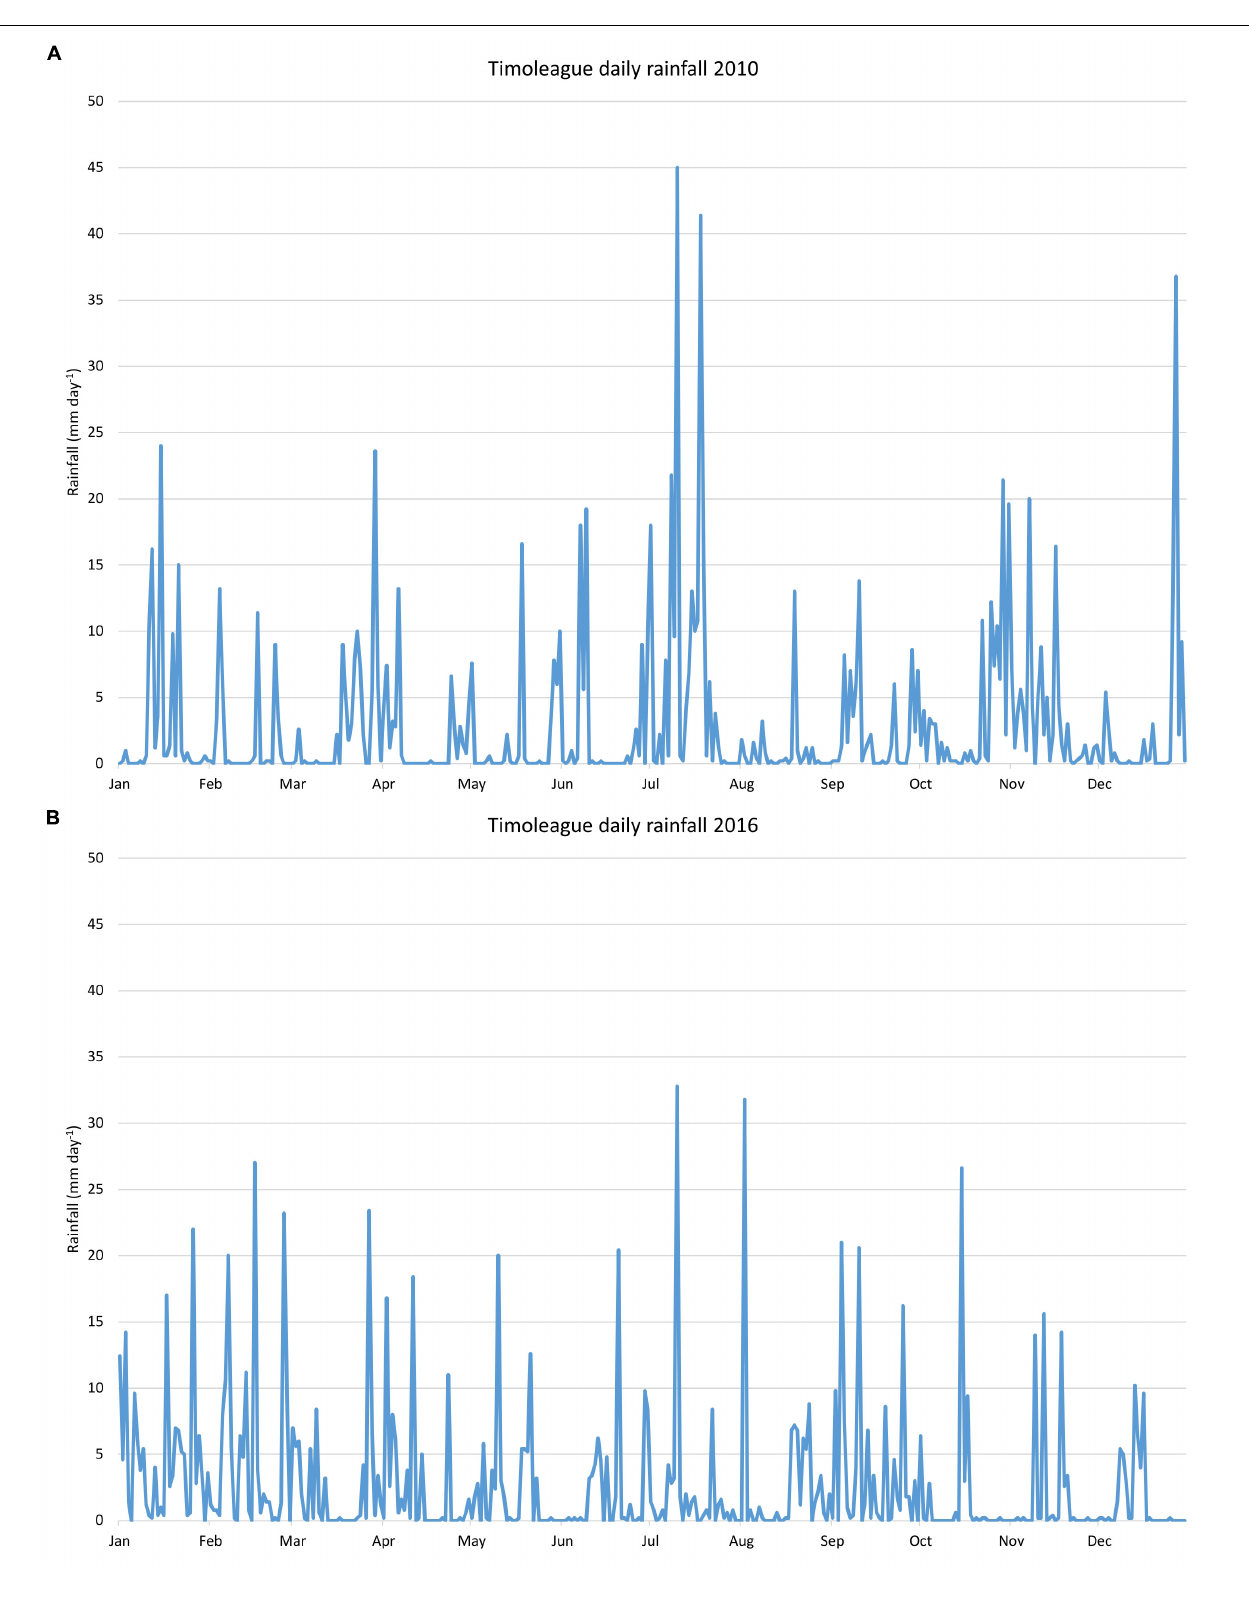
FIGURE 2 | Daily total rainfall in the Timoleague catchment in (A) 2010 and (B) 2016.